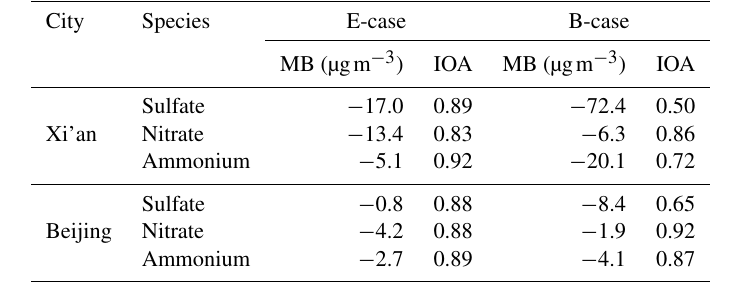
Table 3. Statistical comparisons of simulated and measured sulfate, nitrate, and ammonium concentrations in Xi’an and Beijing.